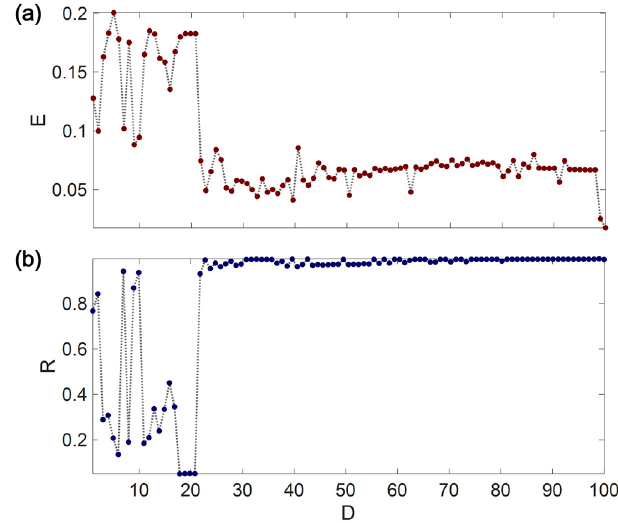
Figure 6. ( a ) The synchronization error and ( b ) parameter 𝑅 values as a function of the coupling strength 𝐷 . The fractional-order 𝛼 is 0.95 .